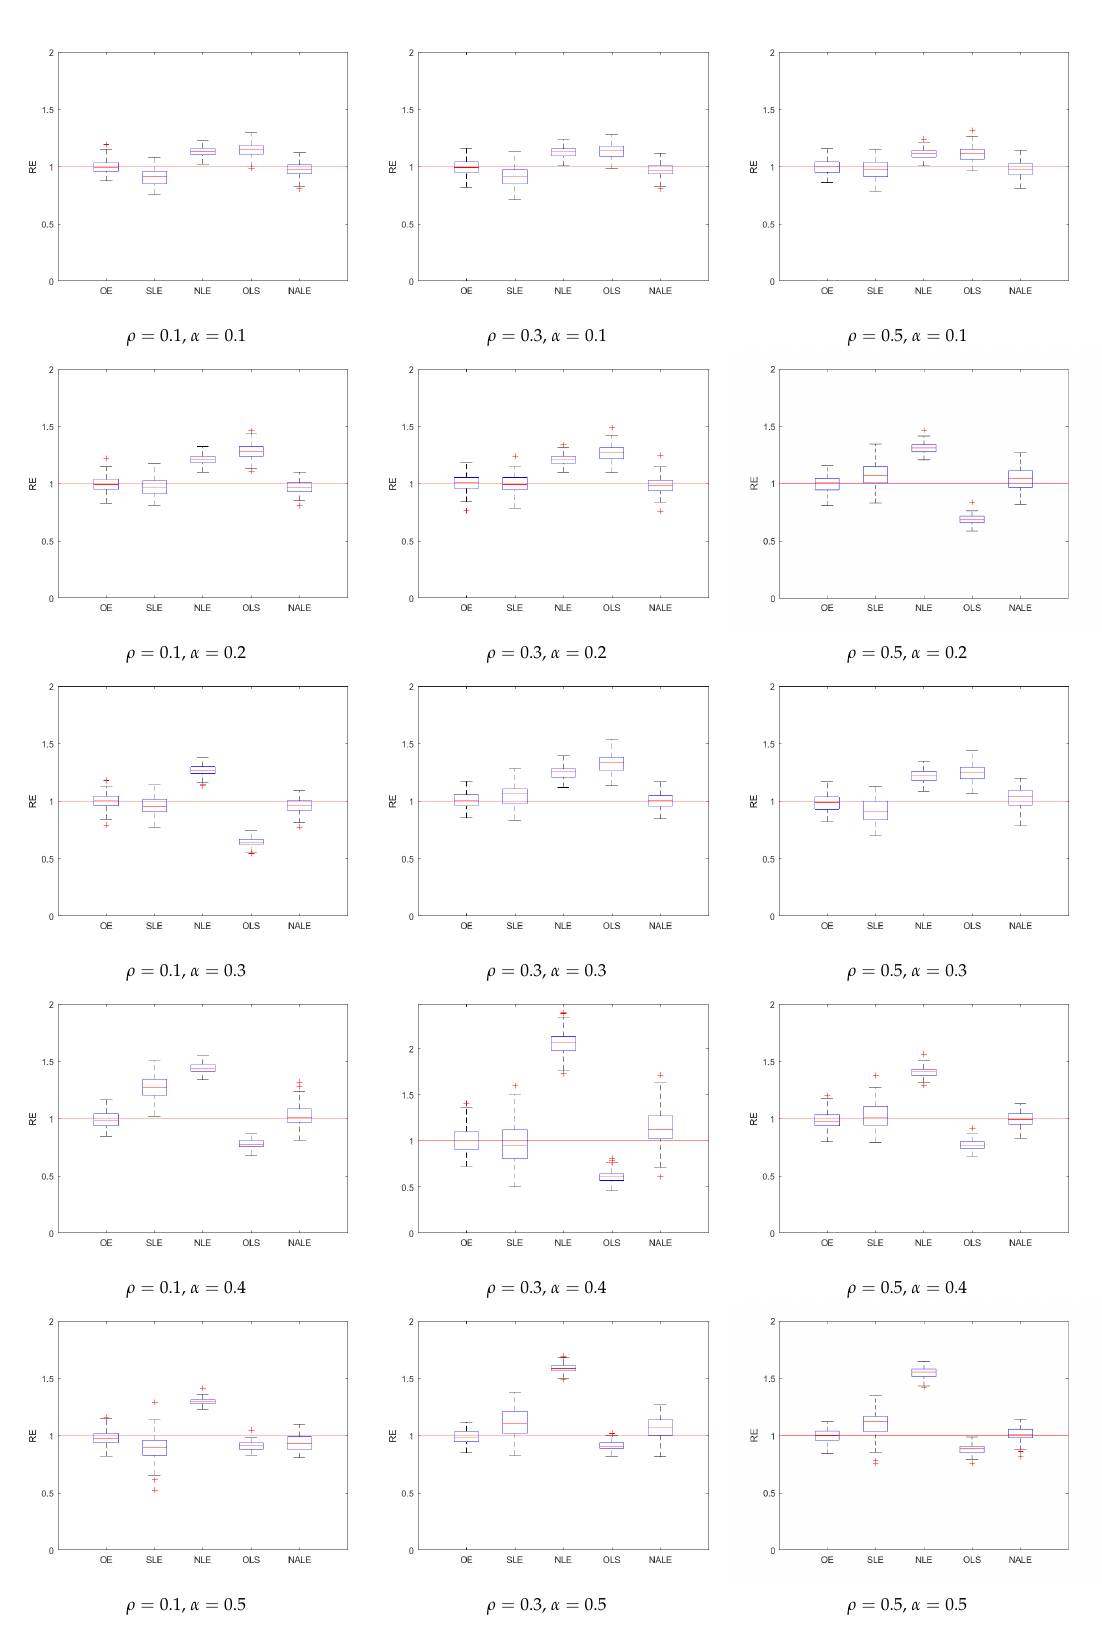
Figure 2. Boxplots of 100 RE values for five estimators, true σ 2 =